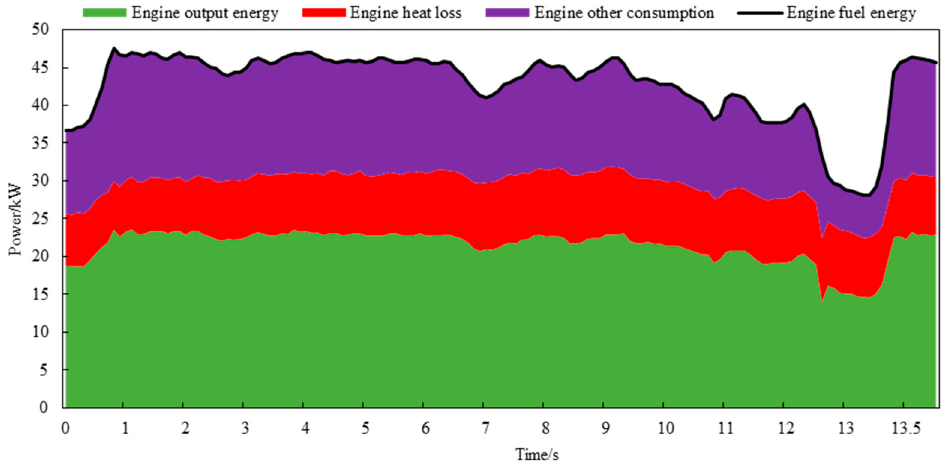
Figure 20. The engine energy flow.